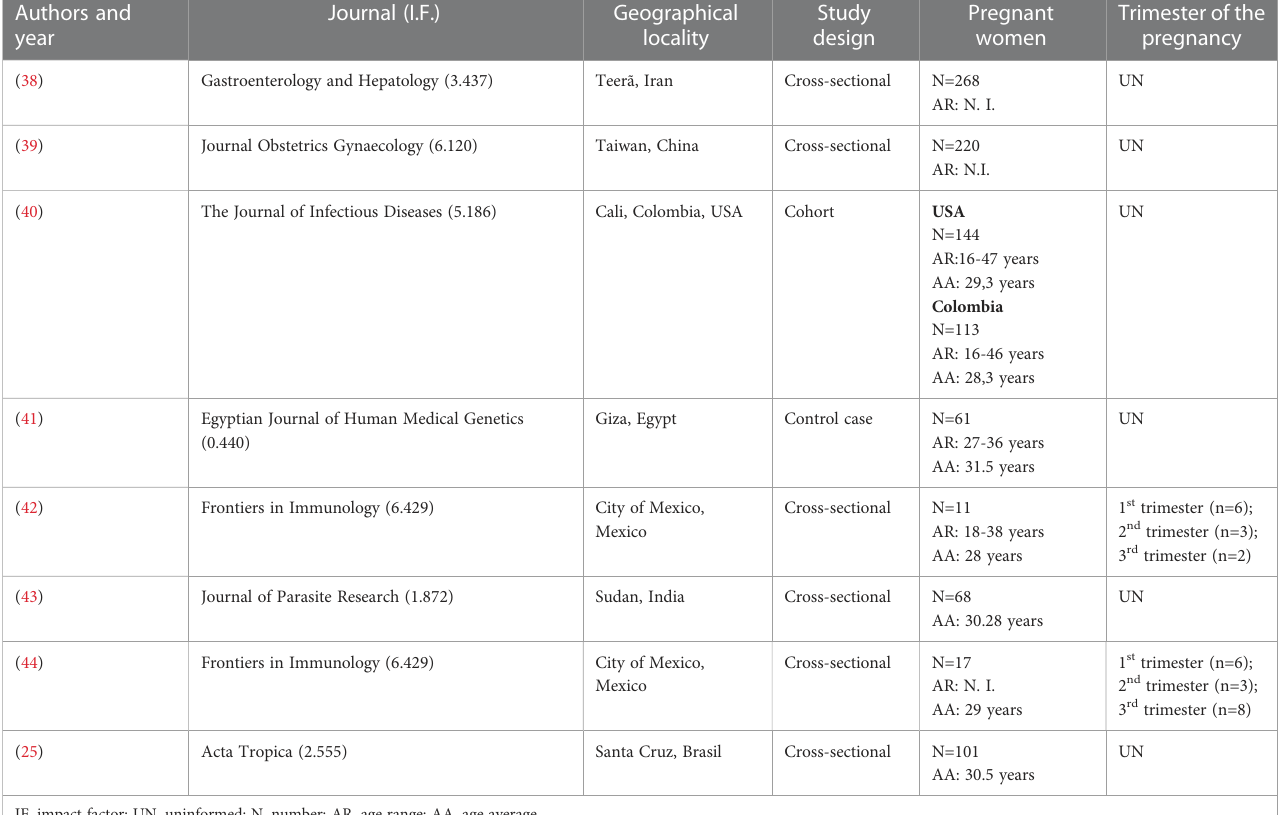
TABLE 1 Description of the studies included in the systematic